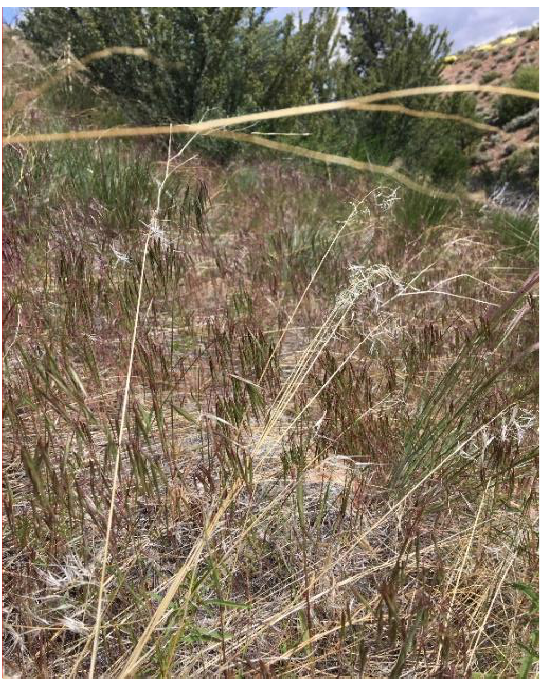
Figure 1. Cheatgrass in Reno (NV, USA) is turning from green to purple as the plants mature.